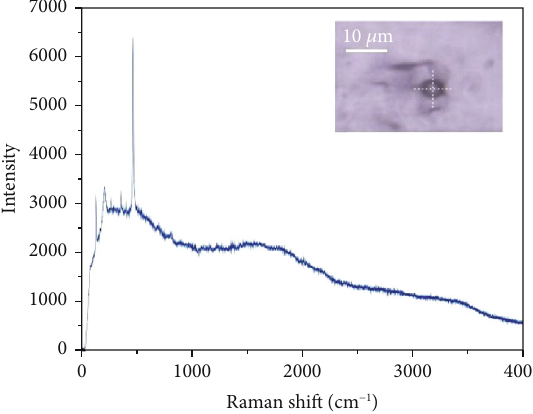
Figure 10: Laser Raman spectra of vapor-phase composition of WG-type fl uid inclusions of the Tieling Cu-Mo